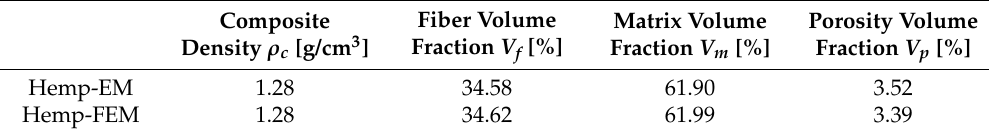
Table 3. Composition of hemp/PLA composites, fabricated with the two different methods.